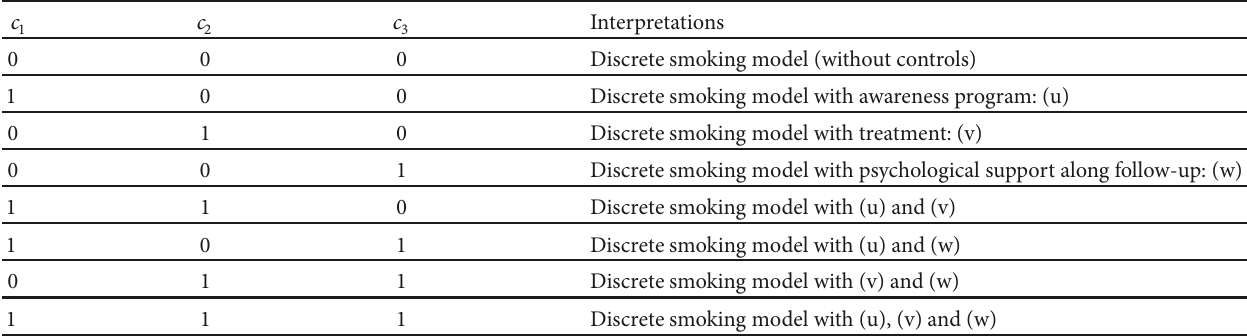
Table 1: Interpretations according to the values of 𝑐 𝑖